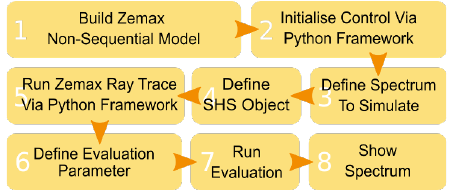
Figure 2: Flow chart of a typical SHS simulation